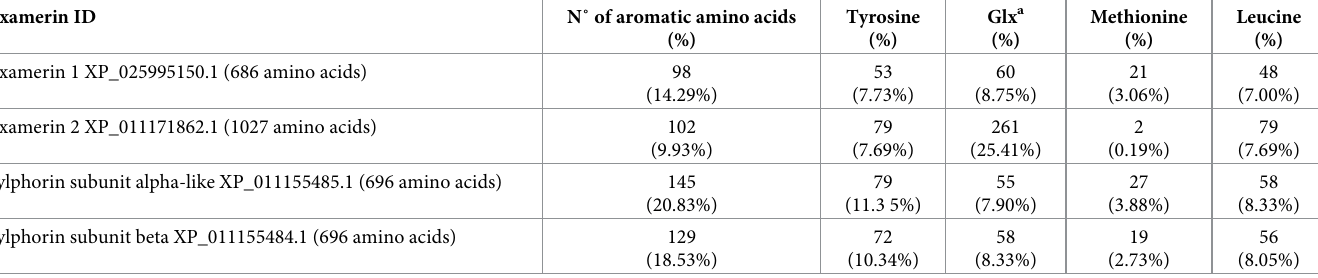
Tyrosine Glx a Methionine Leucine (%) (%) (%) (%) (%)